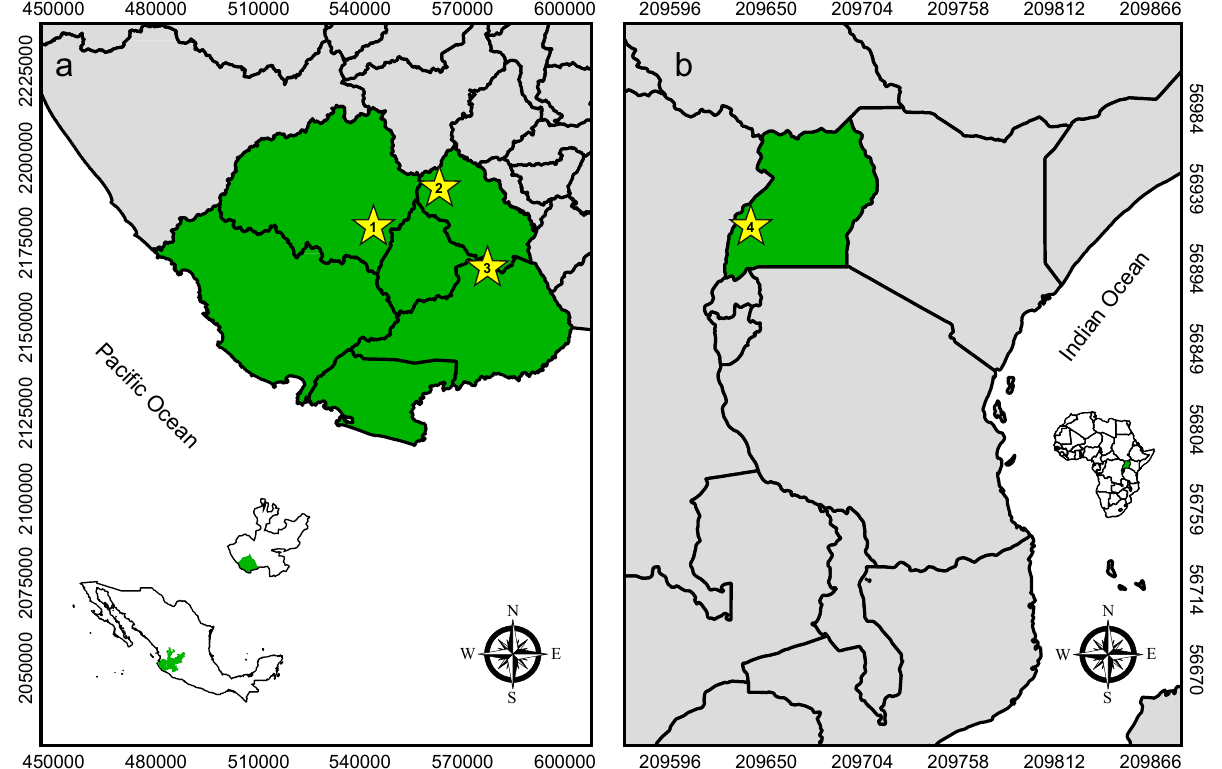
Figure 1. Maps of study sites. ( a ) Sampling locations in Jalisco, México (green area, shown with insets of México and Jalisco). Sites in México are 1: Villa Purificación, 2: Jalocote, and 3: Las Joyas Scientific Research Station. ( b ) Sampling location in Uganda (green, with inset of Uganda in Africa) in Kibale National Park (4), near the Ngogo Research Station. Numbers surrounding maps are latitudes and longitudes (UTM).